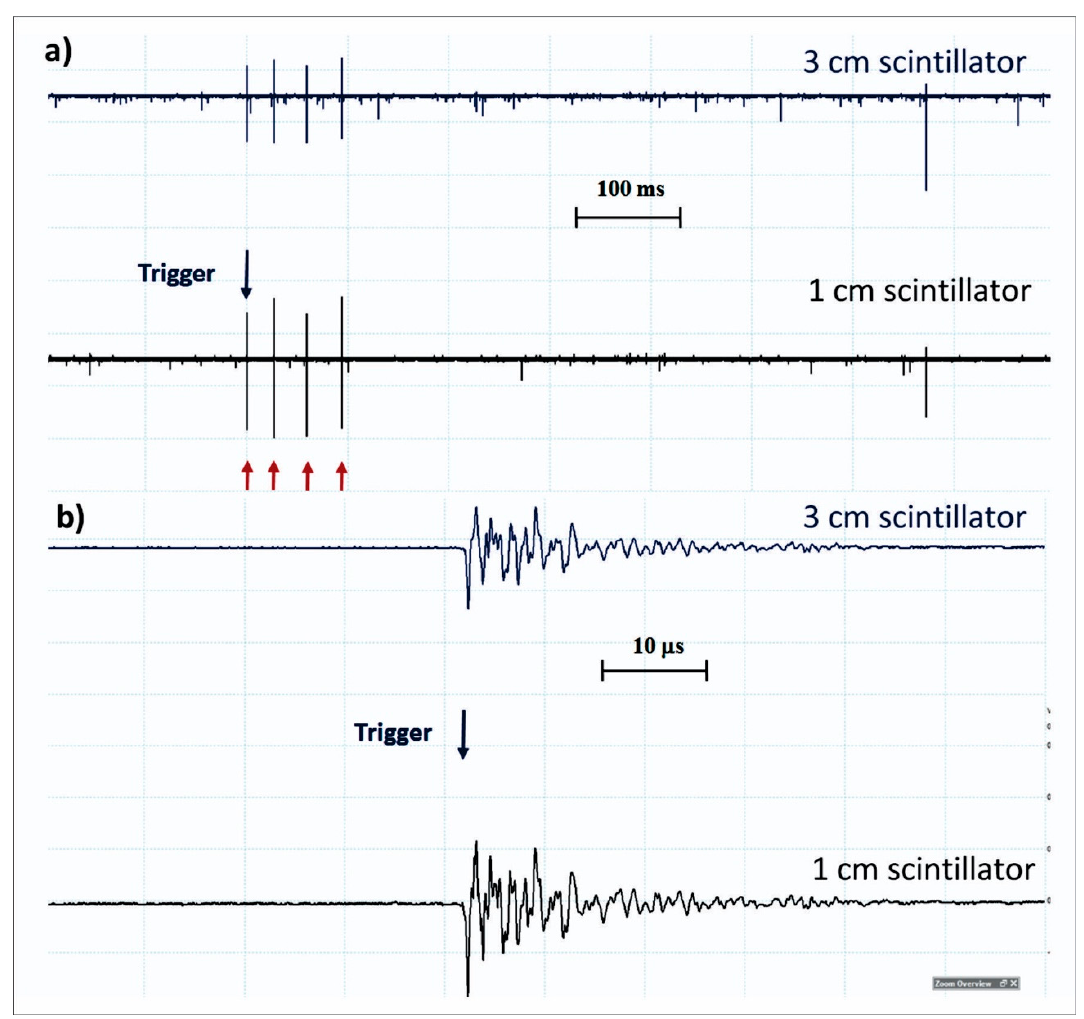
Figure 14. ( a ) “Particle bursts” observed on 14 April 2017 using 1 cm and 3 cm thick plastic scintillators with an area of 1 m 2 in the MAKET experimental hall. The red arrow indicates signals. The frame ( b ) is a zoomed-in version of the data shown in ( a ). The fast waveforms were synchronized with the atmospheric discharge at 11:59:51.75.